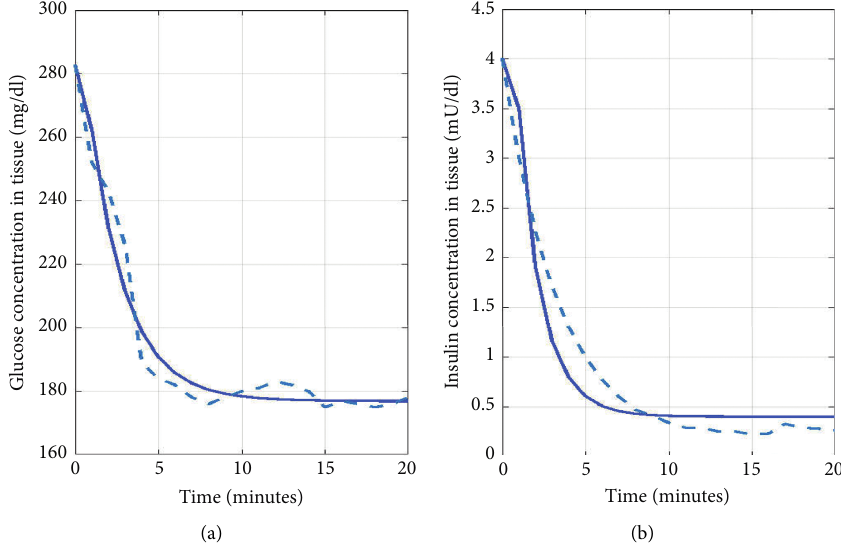
Figure 3: Trends of glucose (a) and insulin (b) concentrations in tissues compared with those of clinical data. The observed data (dashed) and the solution of our mathematical model